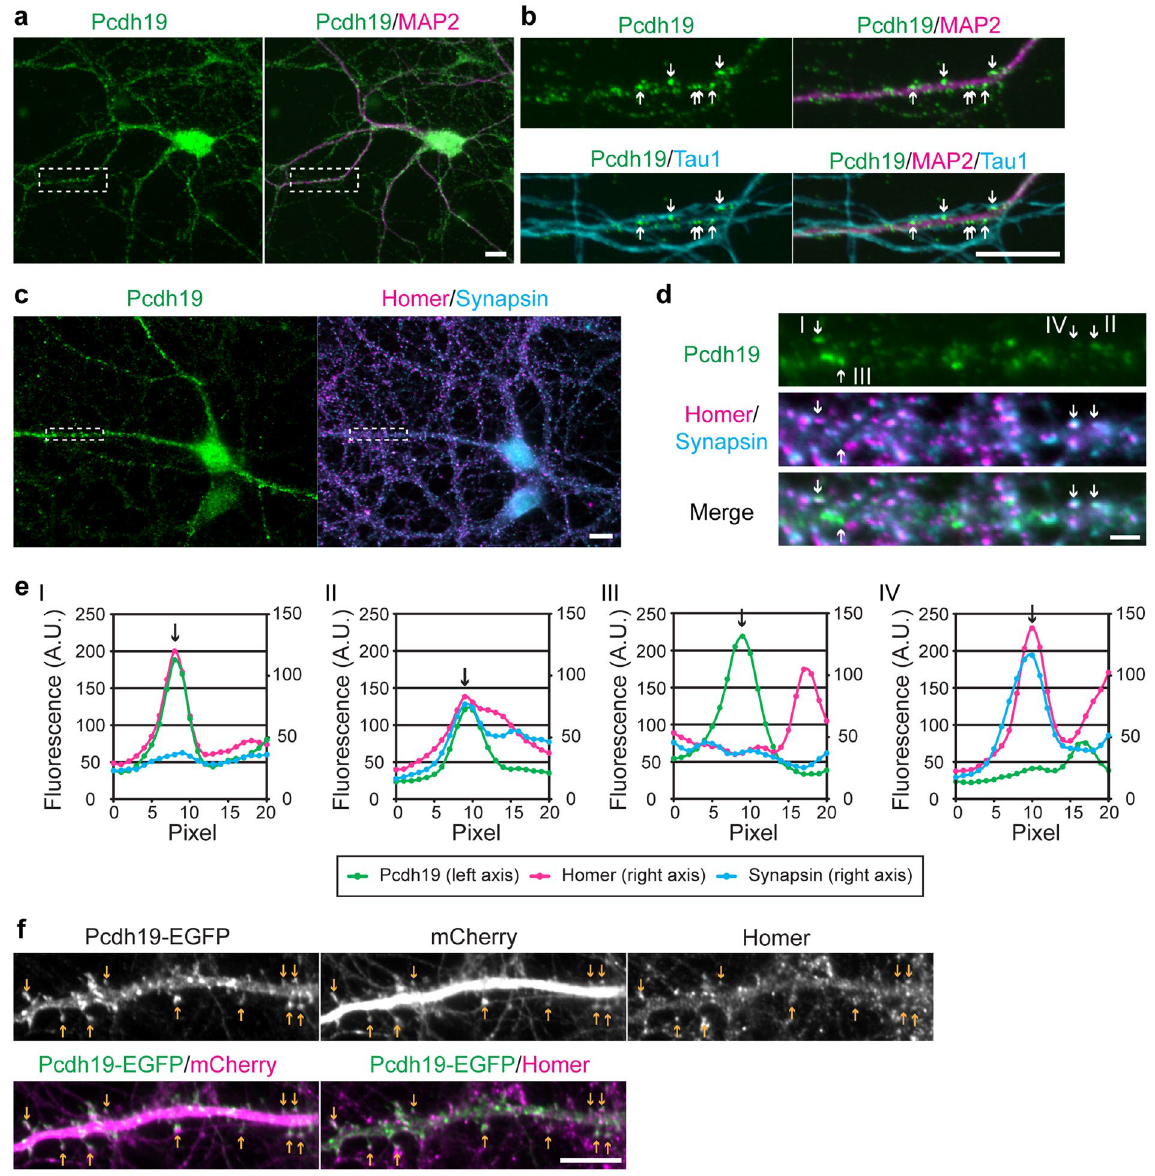
Figure 3. Distribution of Pcdh19 along dendrites of hippocampal neurons. ( a , b ) Pcdh19 protein localization along neurites of cultured hippocampal neurons at DIV7. Anti-MAP2 and Tau1 antibodies were used to visualize dendrites and axons, respectively. ( a ) Pcdh19 localization along dendrites. Tau1 signals are not shown. ( b ) Enlarged images of the boxed region in ( a ). Pcdh19 localizes along dendrites and their signals overlapped with axons along the dendrite. ( c ) Pcdh19 protein localization along dendrites of hippocampal neurons at DIV21. Anti-Homer-1 (Homer) and Synapsin-1/2 (Synapsin) antibodies were used to detect post- and pre- synapses, respectively. ( d ) Localization of Pcdh19, Homer-1 and Synapin-1/2 along the dendrite indicated in the box in ( c ). Representative Pcdh19 signals are indicated by arrows with labels that correspond to those in ( e ). ( e ) Fluorescence intensities at the points indicated by arrows in ( d ). I, colocalization of Pcdh19 with Homer- 1; II, colocalization of Pcdh19 with both Homer-1 and Synaptin-1/2; III, no colocalization of Pcdh19 with Homer-1 or Synapsin-1/2; IV, colocalization of Homer-1 and Synapsin-I/II without Pcdh19. ( f ) Localization of exogenously expressed Pcdh19 and mCherry in hippocampal neurons at DIV21. Pcdh19-EGFP signals colocalized with homer-1. Scale bar, 10 μ m in ( a – c , f ) 2 μ m in ( d